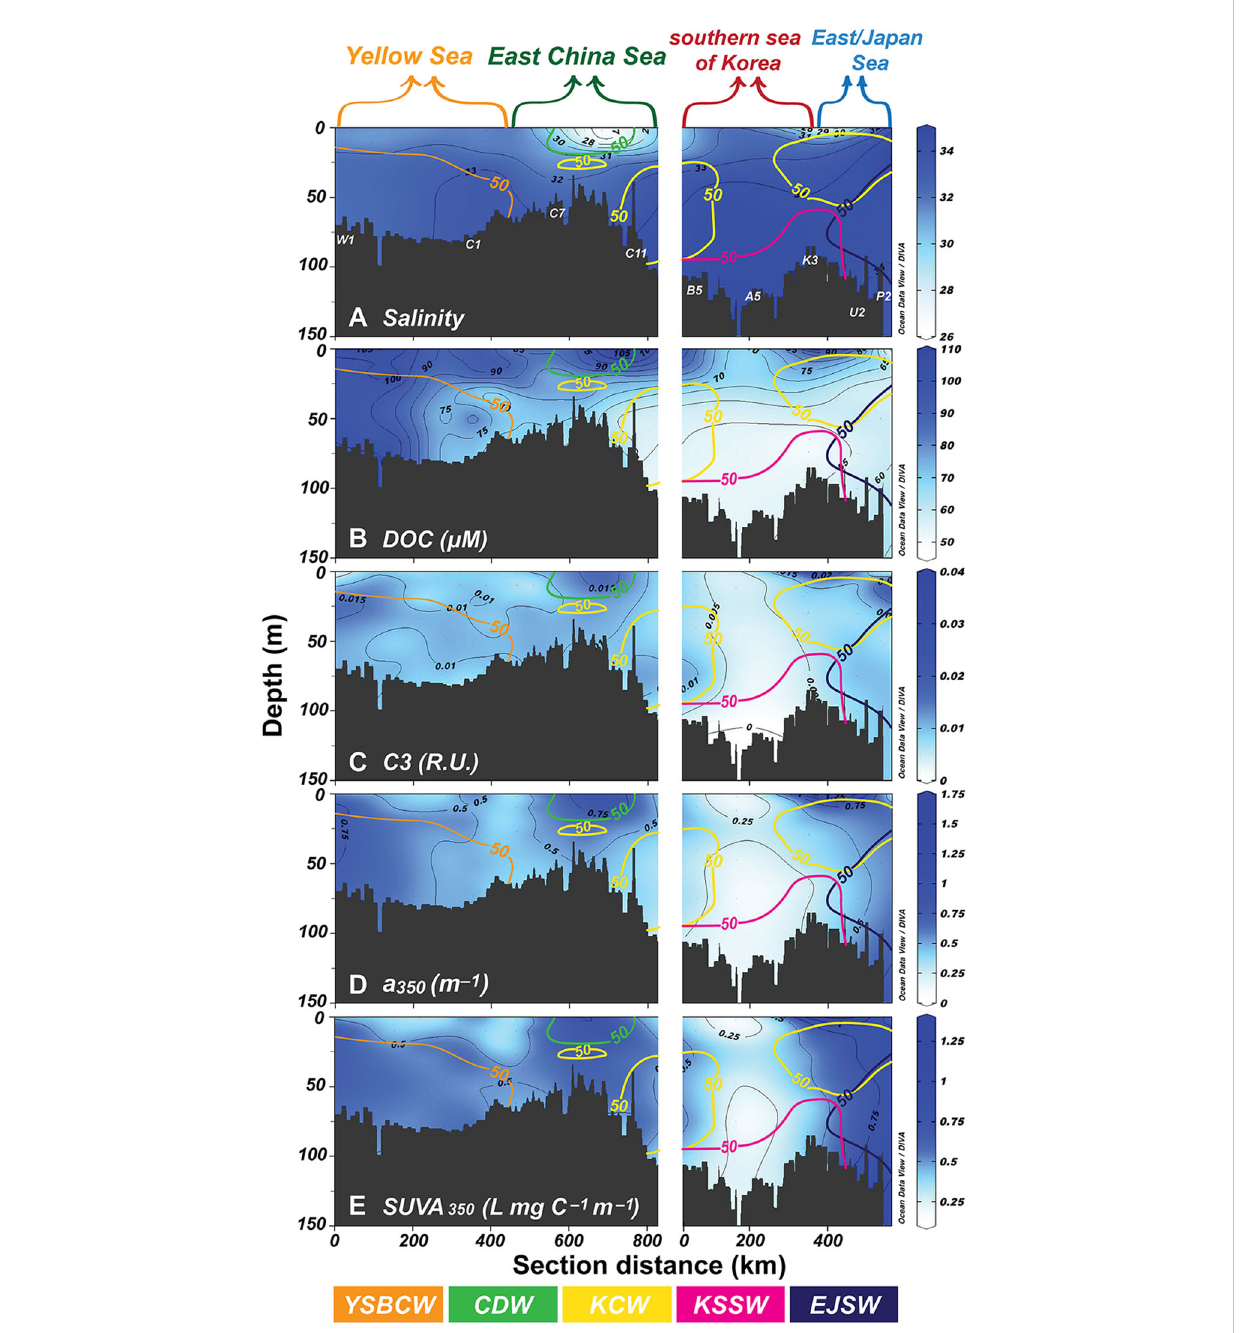
FIGURE 6 Sectional distributions of salinity (A) , DOC concentrations (B) , C3 component (C) , a 350 (D) , and SUVA 350 (E) together with the SWTs along the transect shown in Figure 1. The colored line indicates the 50% of the water mass mixing fraction value calculated by the OMP